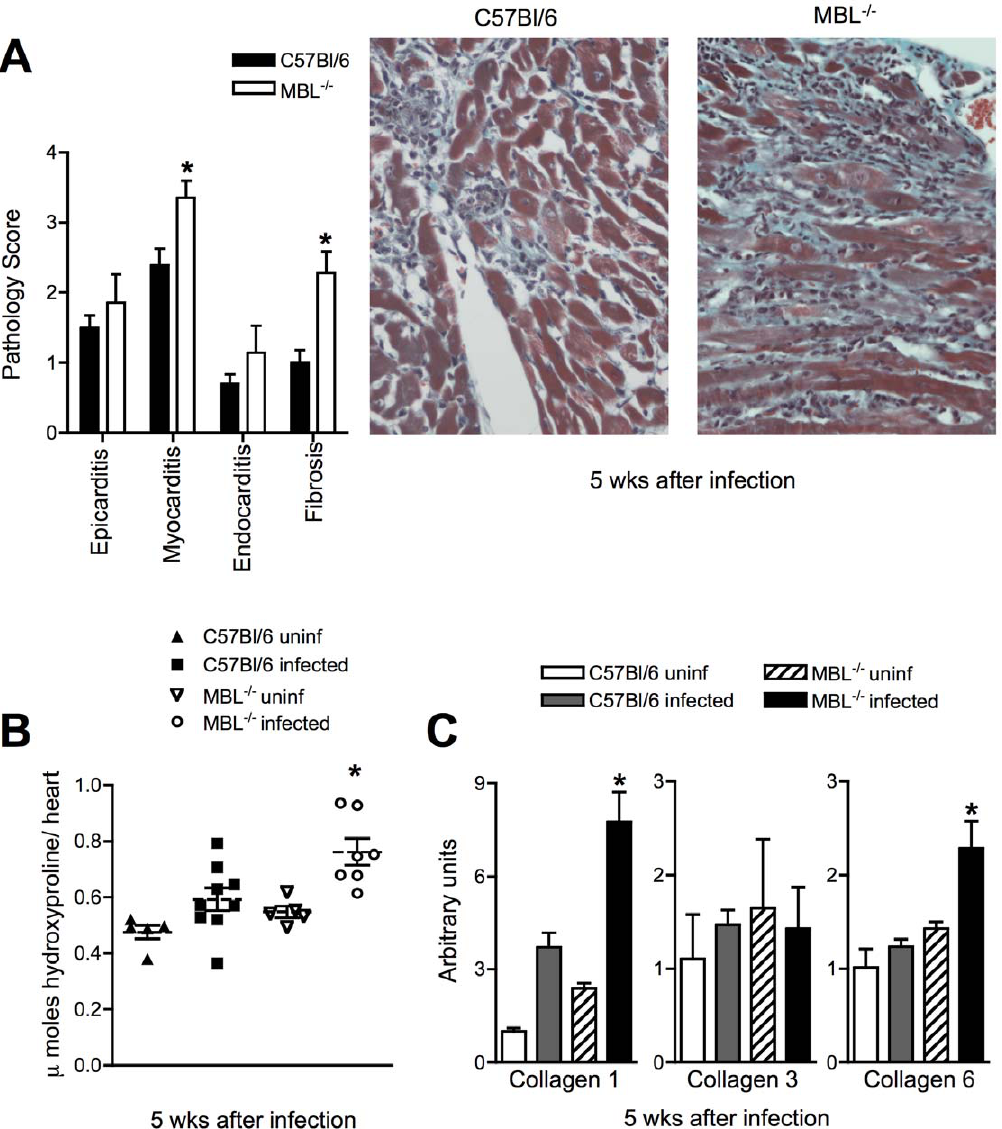
Figure 4. Enhanced cardiac pathology and fibrosis in MBL 2 / 2 infected with T.cruzi Colombiana strain. WT and MBL 2 / 2 mice were infected with trypomastigotes of the Colombiana strain of T. cruzi and hearts from these animals obtained 5 weeks after infection. Hearts were formalin-fixed, paraffin embedded, stained with H&E or Gomori’s trichrome and scored for pathology and fibrosis, respectively, as described under Materials and Methods (A). Right panels show micrographs of Gomori’s trichrome staining for each group. Bars indicate the standard error of the mean (SEM). Uninfected, or WT and MBL 2 / 2 mice infected as in (A) were harvested 5 wks later for determination of hydroxyproline content in total heart (B). Each symbol corresponds to an individual animal, dashed lines represent the mean of each group and solid lines the standard error of the mean (SEM). Heart samples from uninfected controls or from WT and MBL 2 / 2 mice infected as in (A) were obtained and mRNA accumulation of Collagen-1, -3 and -6 determined by real-time PCR (C). The experiments shown are representative of two performed. *, Indicates statistically significant differences between infected WT and MBL 2 / 2 groups.